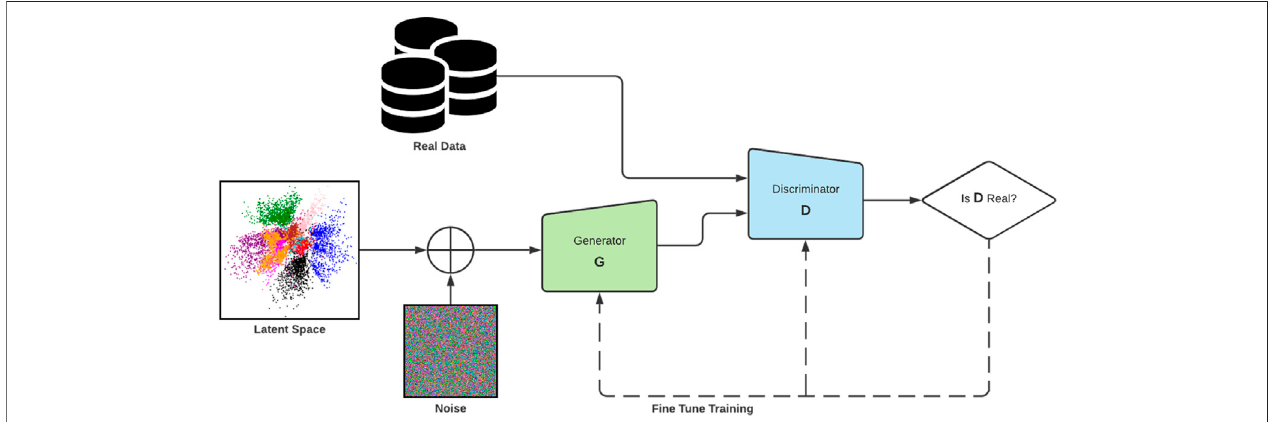
FIGURE 1 | The original GAN architecture as described by Goodfellow et al.